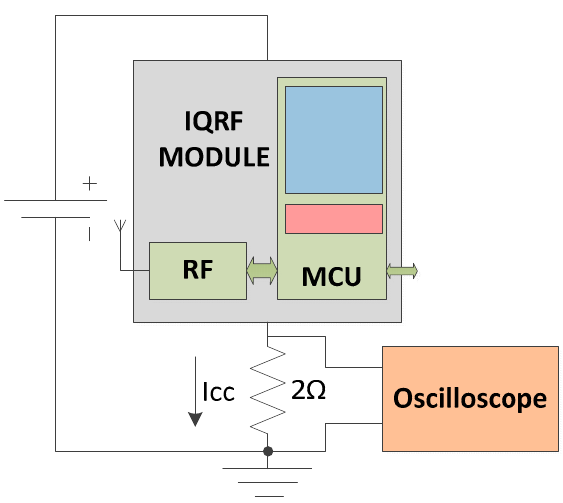
Figure 6. Measurement setup for obtaining the voltage drop over a fixed resistor.